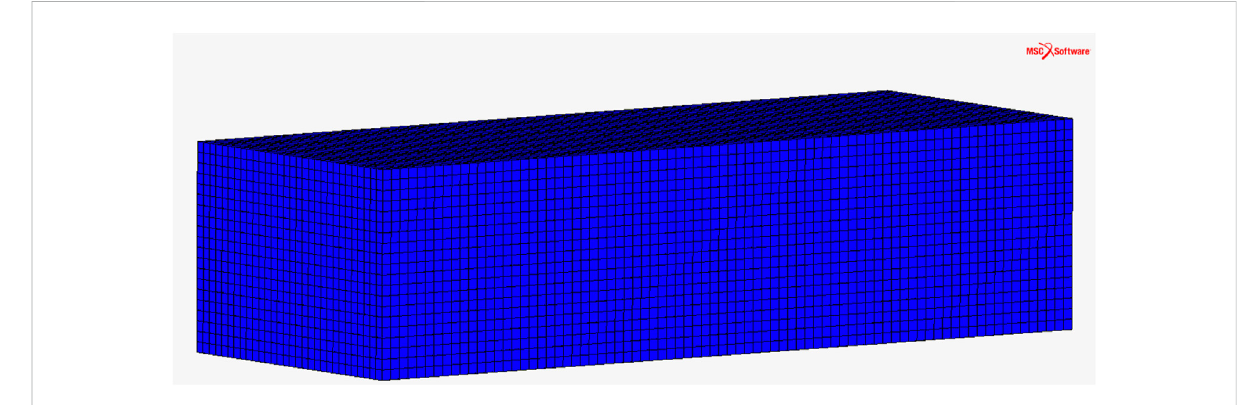
FIGURE 2 Example of FEM used in the parametric FEA.